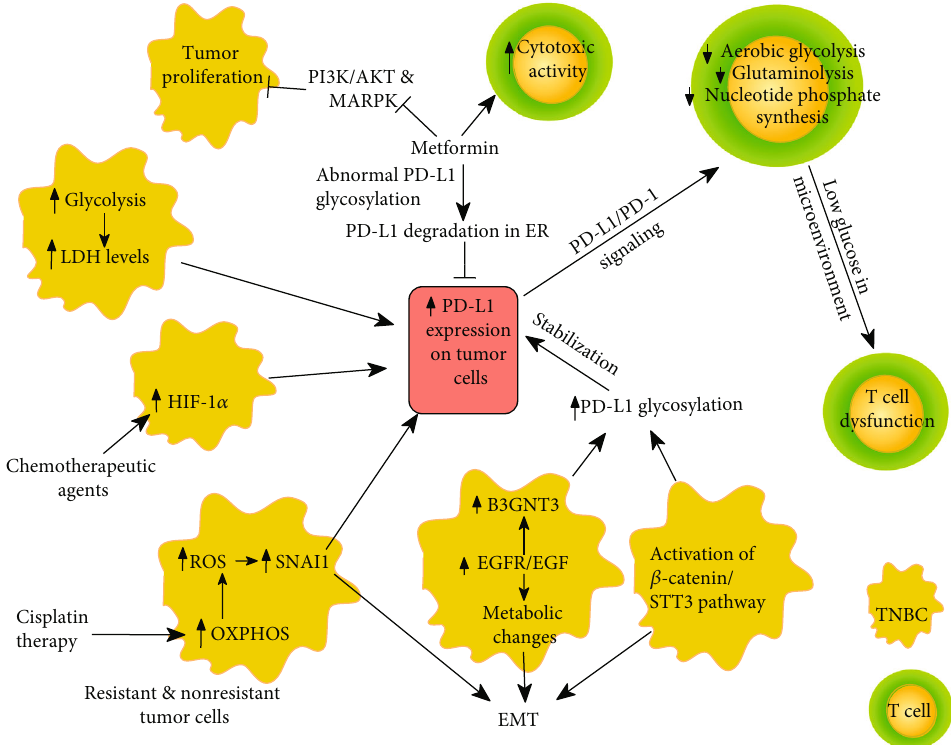
Figure 2: Metabolism-associated mechanisms supporting PD-L1 expression in breast cancer